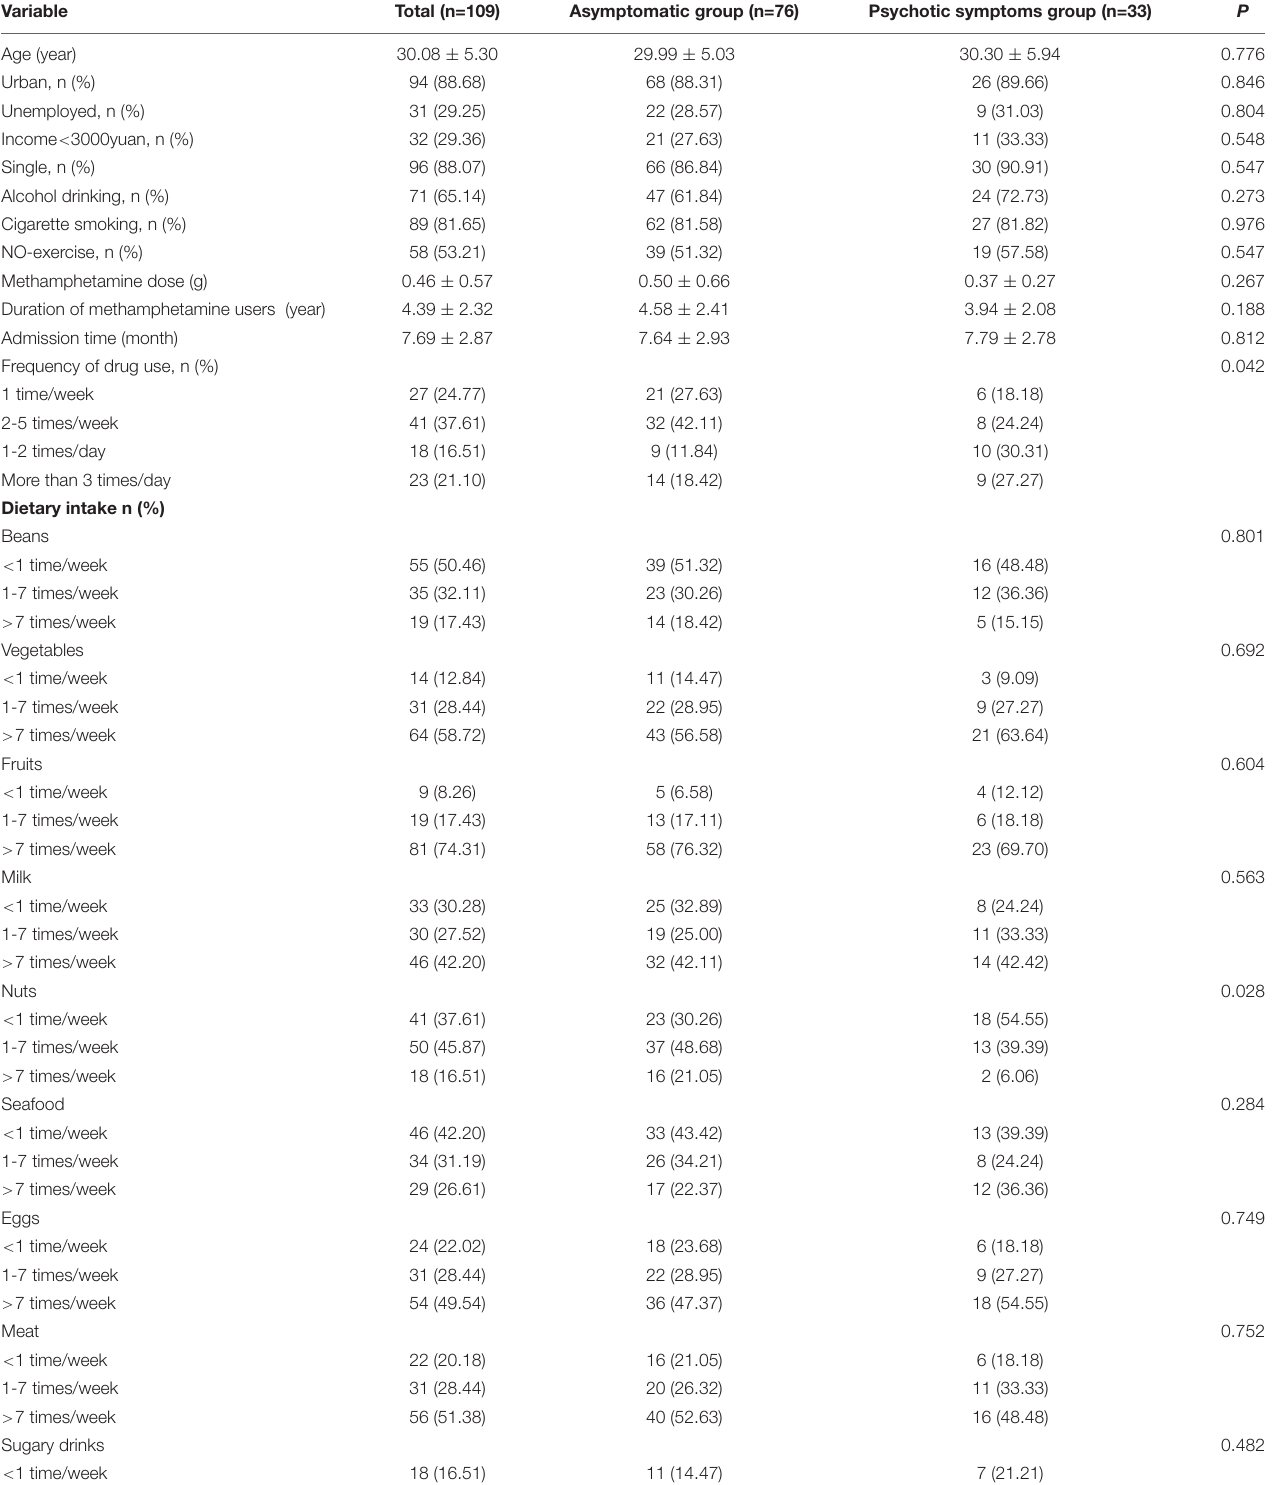
TABLE 1 | Demographic characteristics, MA abuse history, and dietary intake frequency of the